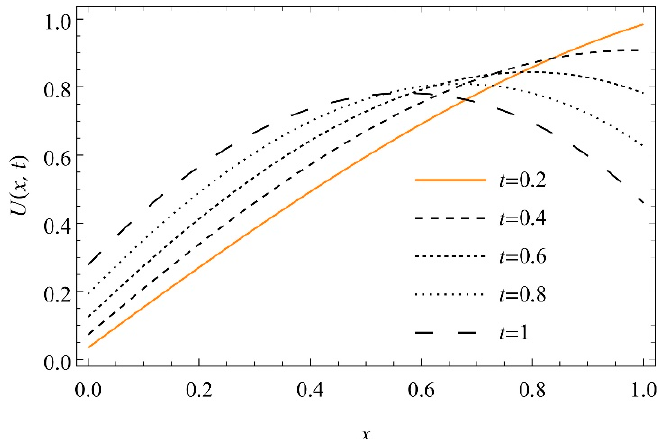
Equation (37). Figure 9. The graph of 𝑈(𝑥, 𝑡) versus depth 𝑥 𝑛 = 1, 𝛼 = 1 , and for 𝑡 = 0.2, 0.4, 0.6, 0.8, 1 for Figure 9. The graph of U ( x , t ) versus depth x at n = 1, α = 1, and for t = 0.2, 0.4, 0.6, 0.8, 1 for